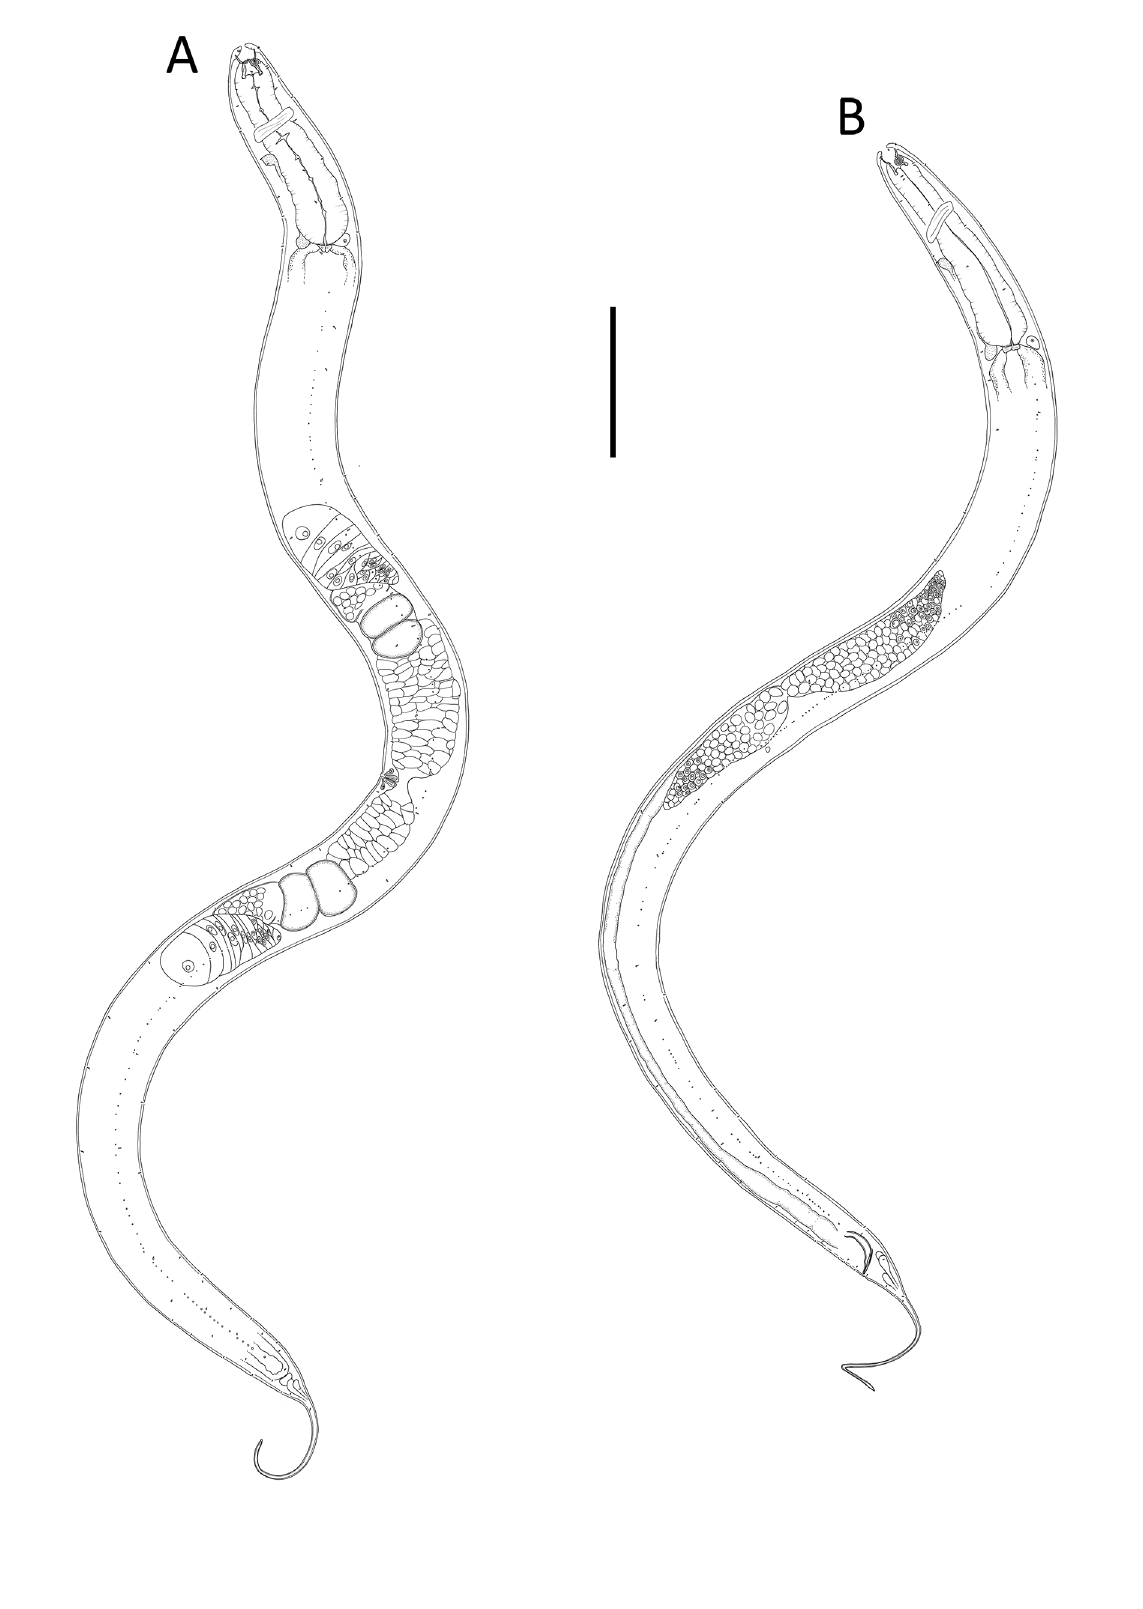
Fig. 8. Halichoanolaimus funestus sp. nov. A . Entire paratype ♀ (NIWA 139249). B . Entire holotype ♂ (NIWA 139248). Scale bar = 250